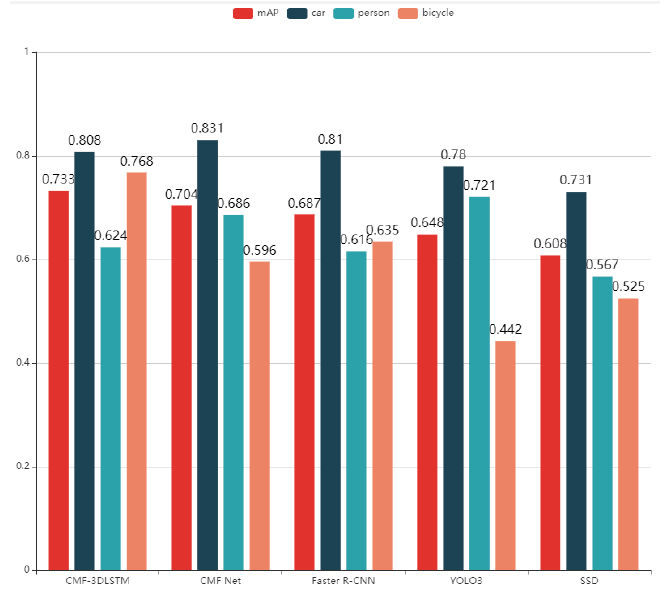
Figure 11. Performance comparison between CMF-3DLSTM and other target detection models.